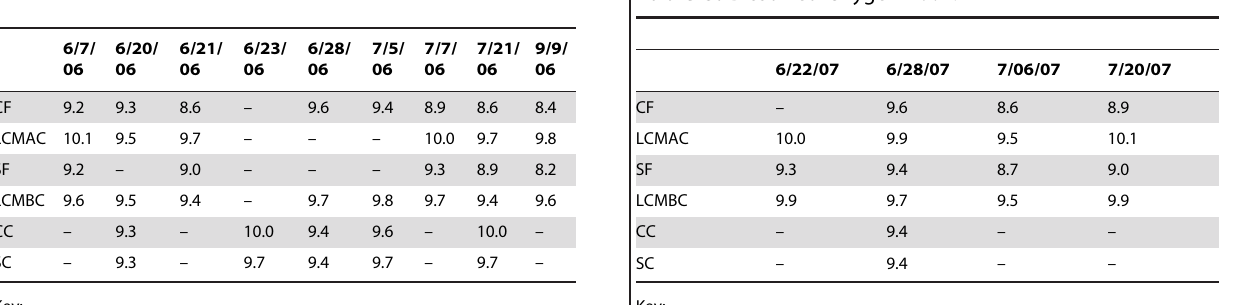
Table 2. Dissolved Oxygen 2006.